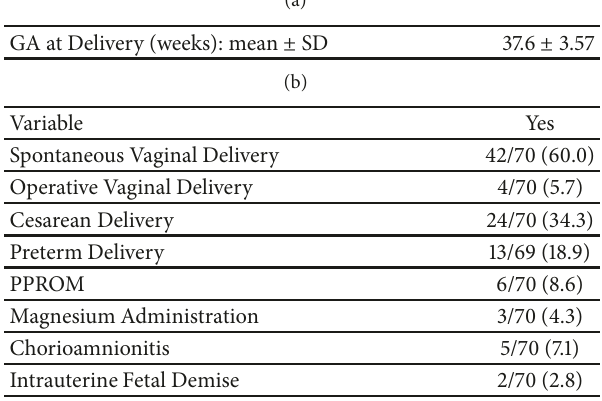
Table 3: Intrapartum variables: N = 73 unless otherwise specified.